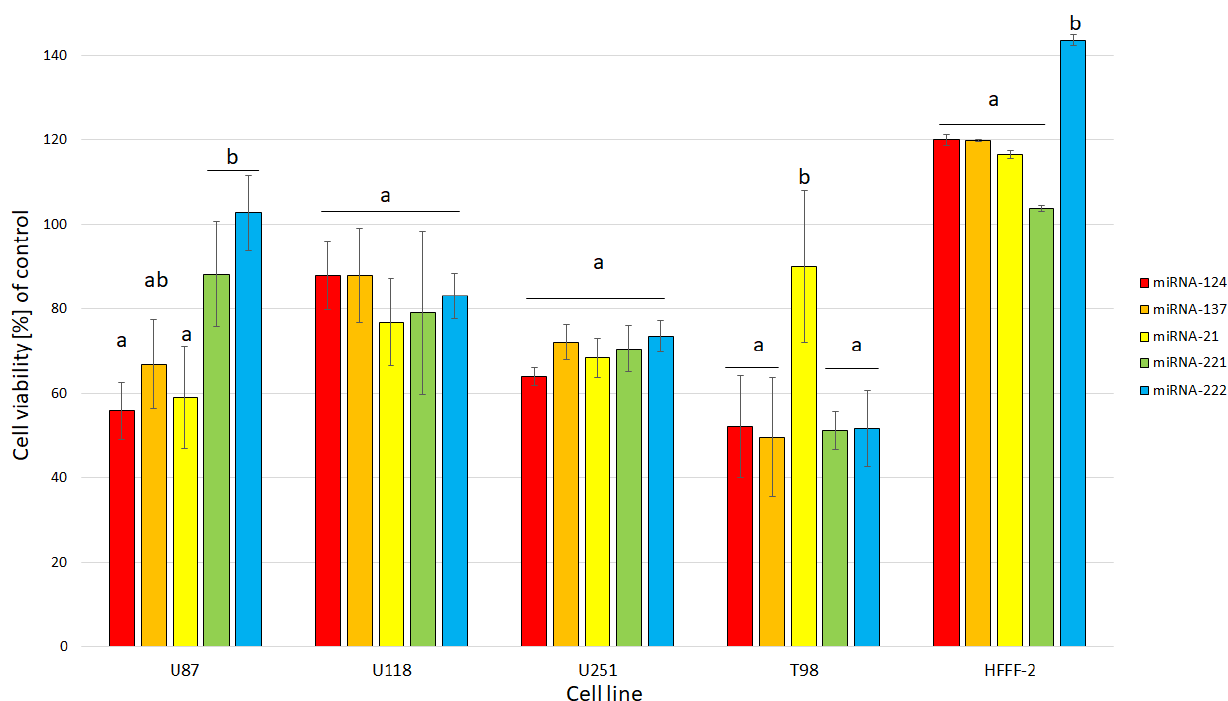
Figure 10. Effect of miRNA-124, miRNA-137 and antisense miRNA-21, -221 and -222 on U87, U118, U251 and T98 GBM cell lines and HFFF-2 human fibroblast viability. Bars represent means with standard deviation (SD) ( n = 3). Notes: Different lowercase letters (a, b) within columns indicate significant differences between the miRNA ( p < 0.05).